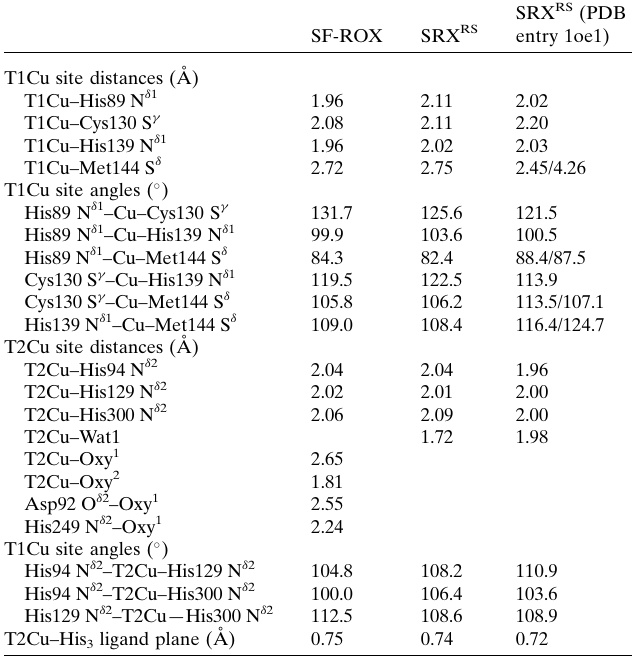
Table 2 Copper-site